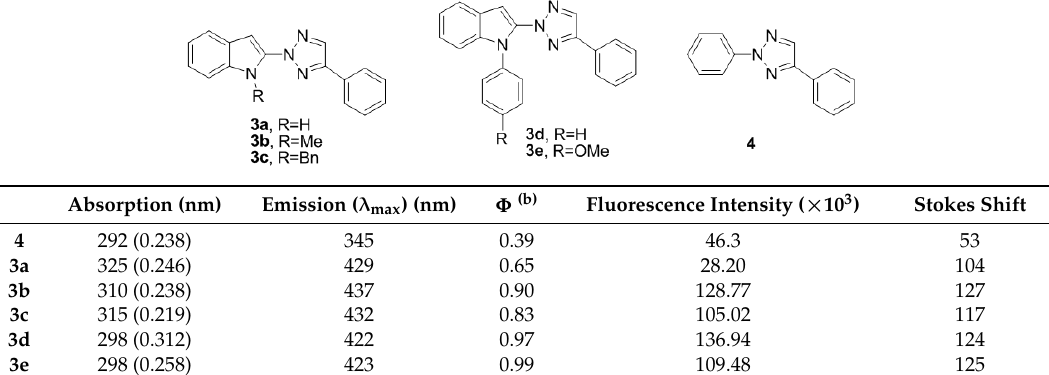
Table 1. Fluorescence emission behavior of compounds with different Indole N -substitutions (a) .